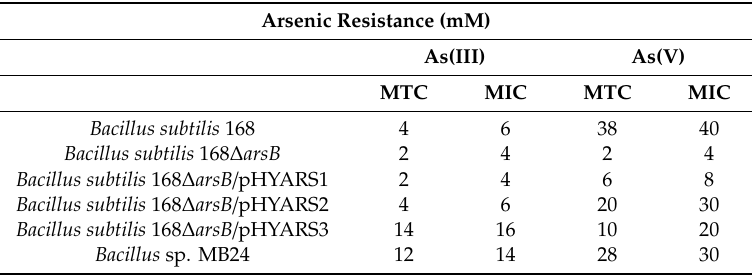
Table 1. Complementary effect of the ars1 and ars2 operon.